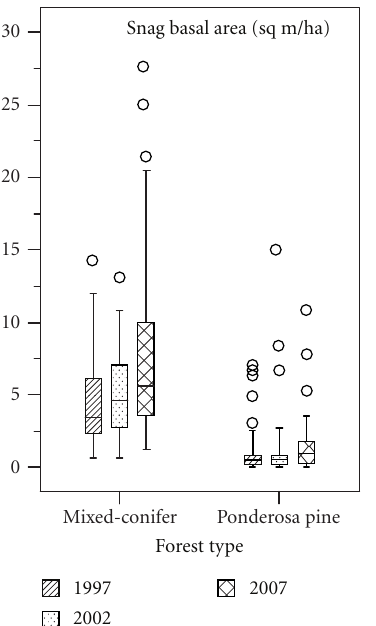
Figure 3: Trends in basal area (m 2 /ha) of snags in northern Arizona mixed-conifer and ponderosa pine forest, 1997 to 2007. Boxes indicate the interquartile range (25th to 75th percentile), the line within the box indicates the median, and the external lines show the range in the data excluding outliers (circles, defined as observations more than 1.5 box lengths outside the box).